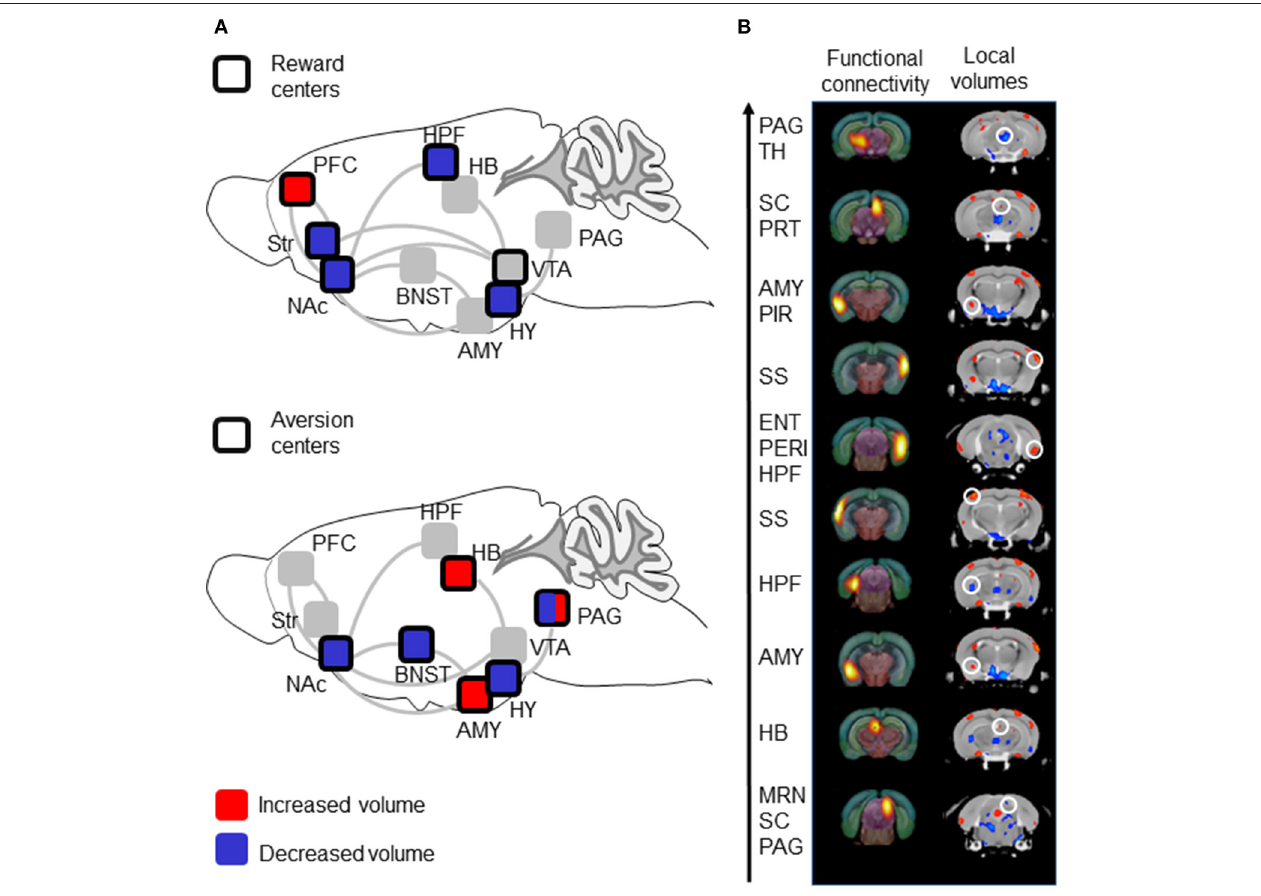
FIGURE 2 | Volumetric data show decreased volumes in reward centers with contrasted effects in aversion centers, and show correspondence with previous Rs-fMRI data. (A) Summary of volumetric analysis. Reward centers show reduced volumes while aversion center show both reduced and increased volumes. The scheme is adapted from Darcq and Kieffer (2) and shows main brain structures involved in reward/aversion, as well as addiction. Top: Areas belonging to reward circuitry are highlighted (dark square) and volume alterations in MOR KO mice are color-coded. Bottom: Areas belonging to aversion circuitry are highlighted (dark square) and volume alterations in MOR KO mice are color-coded. PFC, Prefrontal cortex; PAG, Periaqueductal Gray; TH, Thalamus; AMY, Amygdala; SC, Superior Colliculus; PRT, Pretectal Region; PIR, Piriform area; SS, Somatosensory cortex; ENT, Entorhinal area; PERI, Perirhinal area; HPF, hippocampal; MRN, Midbrain Reticular Nucleus; HY, hypothalamus; VTA, ventral tegmental Area; BNST, Bed nucleus of the stria terminalis. (B) Correspondence of functional nodes (Rs-fMRI) and regions (DBM) showing significant modifications in MOR KO from our previous study ( 14) and in this study, respectively. The 10 nodes with highest number of statistically significant FC changes from the Rs-fMRI study are represented in the left column, and ranked (arrow) from higher (top) to lower (bottom) modifications (14). Volumetric differences between MOR KO and CTLs in this study are represented in the right column. Comparable coronal sections are displayed, and a white circle highlights local volume changes corresponding to the 10-top